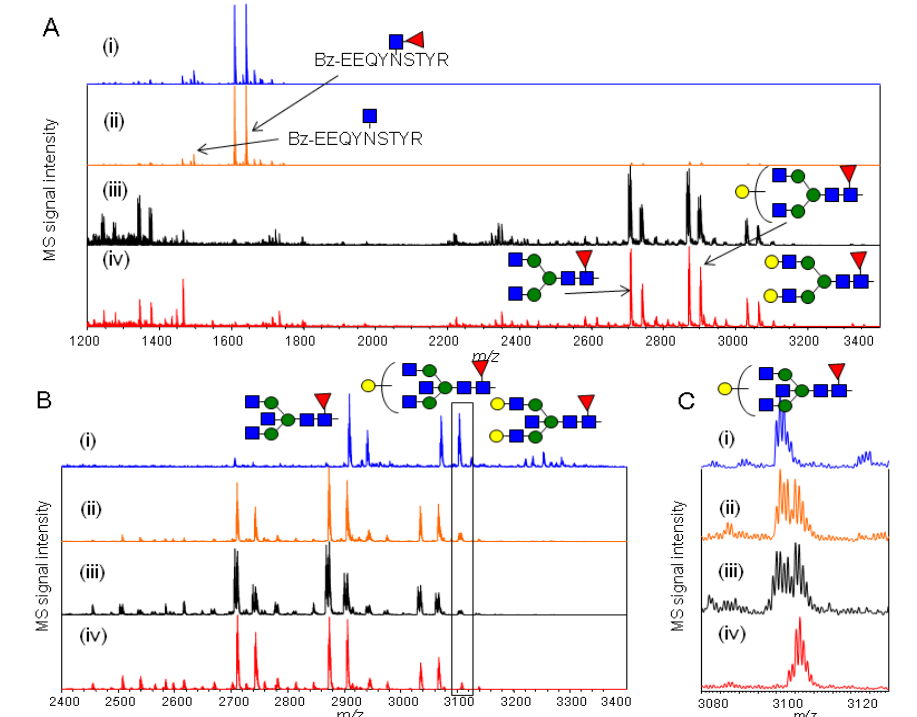
Figure 5. ( A ) MALDI-TOF MS spectra of (i) Bz-labeled hIgG glycopeptides reacted